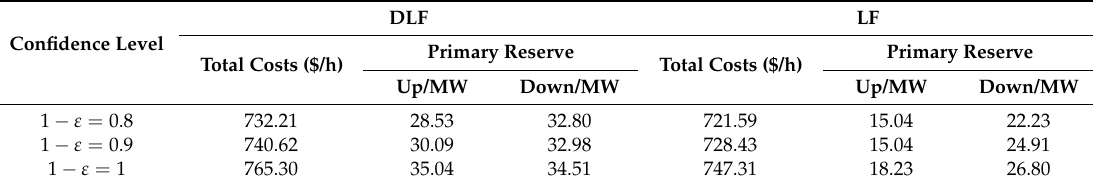
Table 5. Dispatch results comparison based on LF and